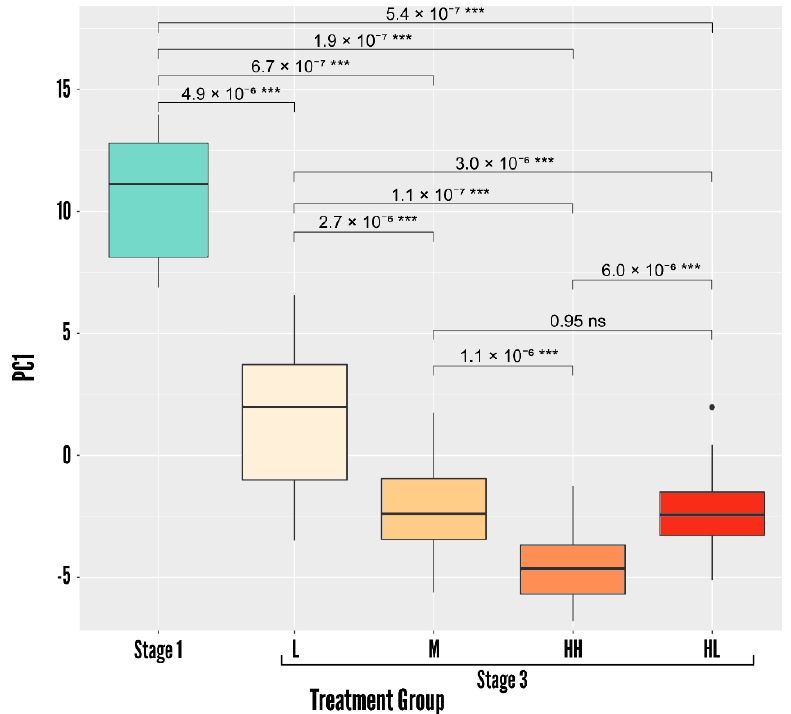
Figure 5. Boxplot of the first principal component value of image pixels at Stage 1 and 3 by treatment group. Bars between treatment groups show the pairwise t- test p -value and indicate the significance group. Bars between treatment groups show the pairwise t -test p -value and indicate the significance of the difference in means (*** = p -value < 0.01, ns = not significant). of the difference in means (*** = p -value < 0.01, ns = not